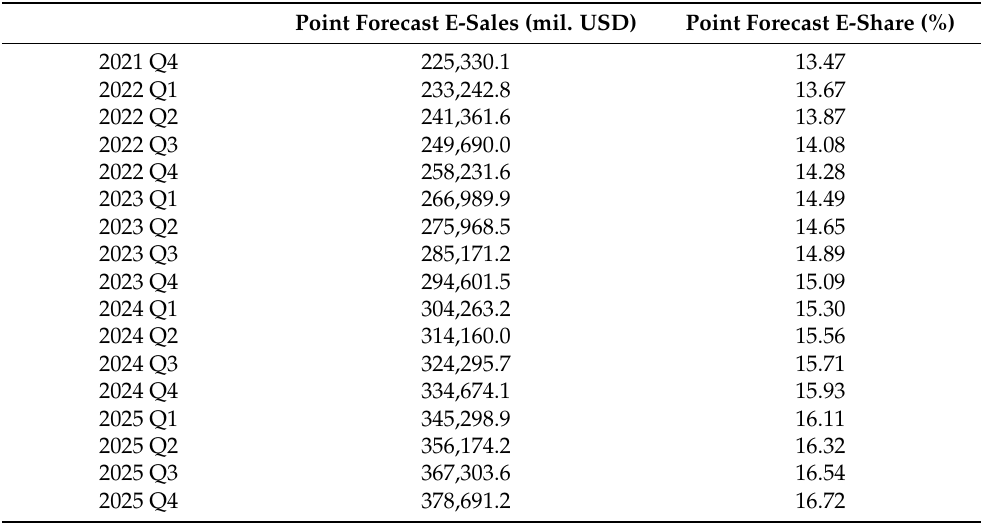
Table 5. Trend estimation from 2021Q4 to 2025Q4 for e-sales (ECOMSA) and e-share (ECOMPTCSA). Point Forecast E-Sales (mil.